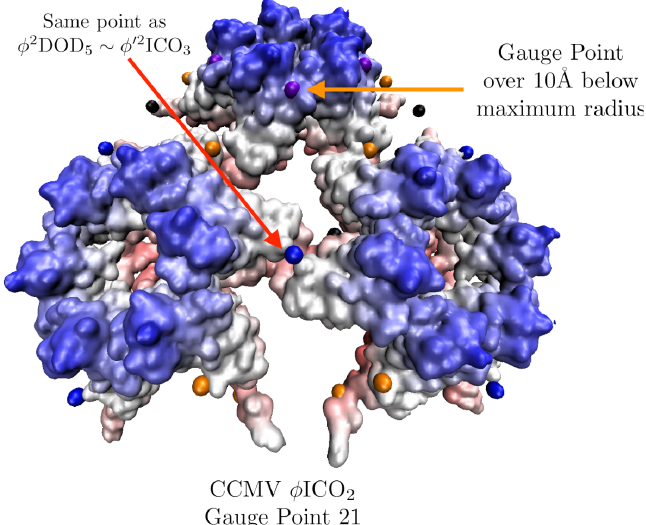
Figure 11. A section of the swollen CCMV capsid radially colored and fitted with φ ICO 2 . In our fitness measure we consider all gauge points which are near protrusions. In this example, we see how a point array can have a low RMSD value, but not match the protruding features well and therefore be excluded later. In this case Gauge Point 21 is 10 Å below the most external atoms, and the other gauge points which sit atop the blue sections are the better